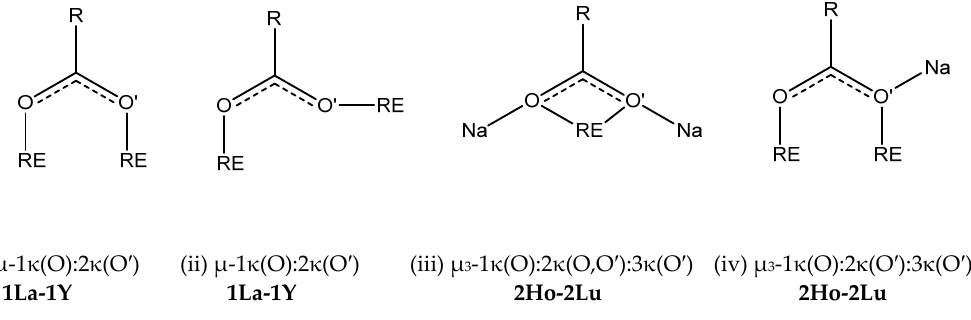
Figure 3. Different coordination modes observed for carboxylate ligand (3-furoate) in rare earth complexes. (i): syn ‐ syn (ii): syn ‐ anti .